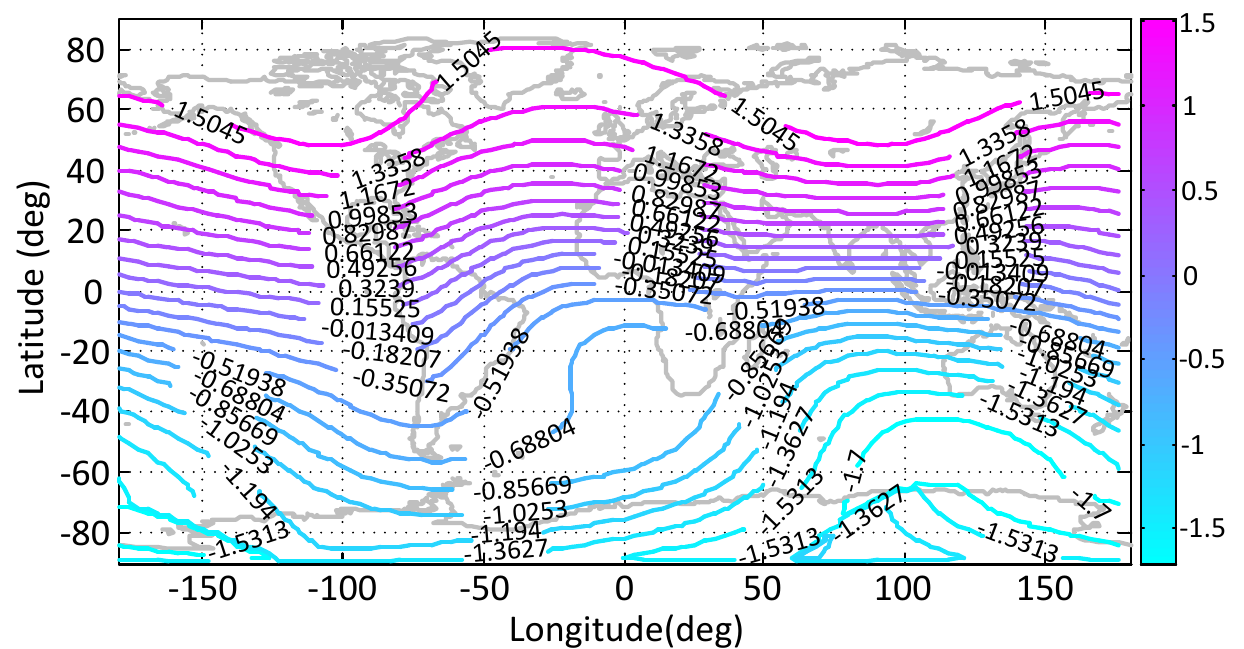
Figure 1. The global distribution of σ for the P-band system in the year 2016 (unit: